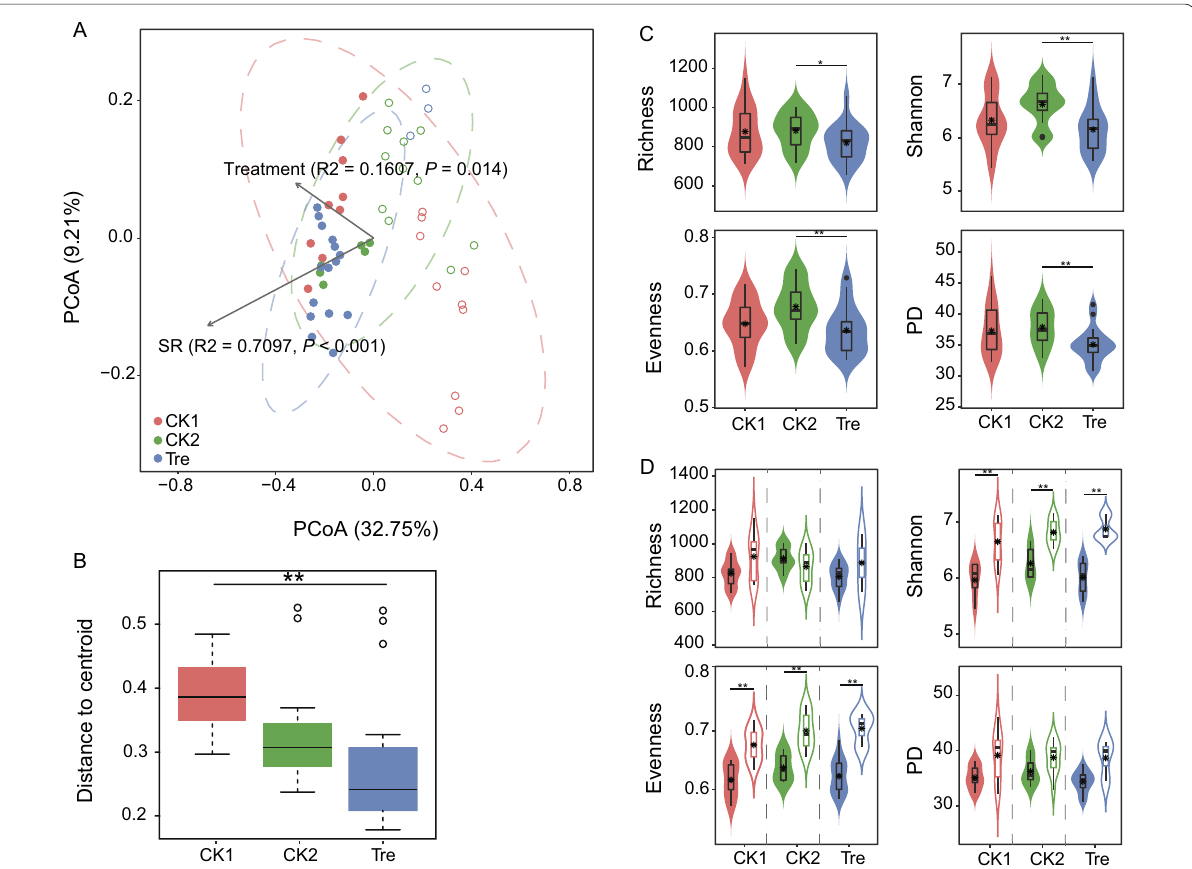
Fig. 2 Diversity of gut microbiota. A Principal coordinates analysis plots of gut microbiota Bray–Curtis beta diversity for treatment and survival ratio (SR). The dotted ellipses with corresponding color for treatment represent the 95% confidence interval. The hollow circle represents shrimp survival ratios of 70% (SL), while the solid circle represents shrimp survival ratios of > 70% (SH). B Boxplot of Bray–Curtis distance between samples and ≤ group centroids (** P < 0.01, Tukey’s ’Honest Significant Difference’). C Alpha-diversity indexes of gut microbiota for treatment (* P < 0.05, ** P < 0.01, Mann–Whitney U test). D Alpha-diversity indexes of gut microbiota for SR in each treatment group. The hollow represents SL, while the solid represents SH (* P < 0.05; ** P < 0.01; Mann–Whitney U